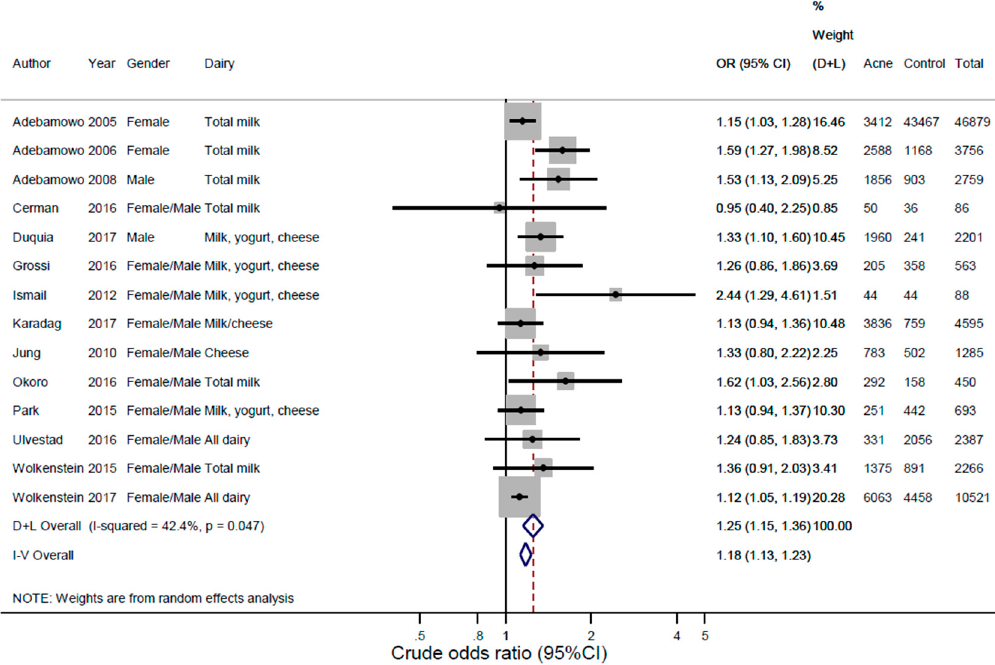
Figure 2. Meta-analysis of dairy intake and acne vulgaris: individual studies. The figure shows the individual studies and the unadjusted pooled random effect estimate from the meta-analysis of dairy intake and acne vulgaris. I 2 (%): I -square heterogeneity expressed as percentage. p -value(het): p -value from Cochran’s Q -statistic assessing heterogeneity. D + L: DerSimonian and Laird pooled random effects estimates. See Table 1 for references.